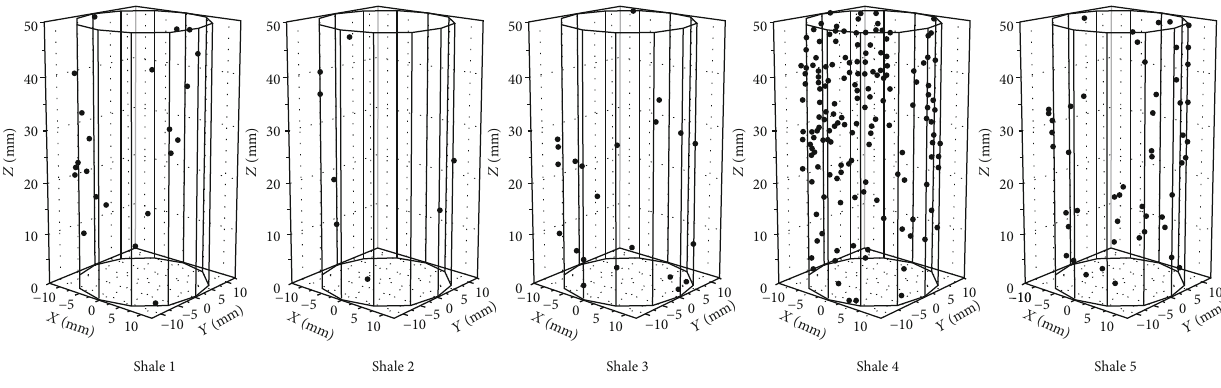
Figure 8: AE location results of the samples. Table 3: The permeability and porosity before and after loading. Before loading After Sample